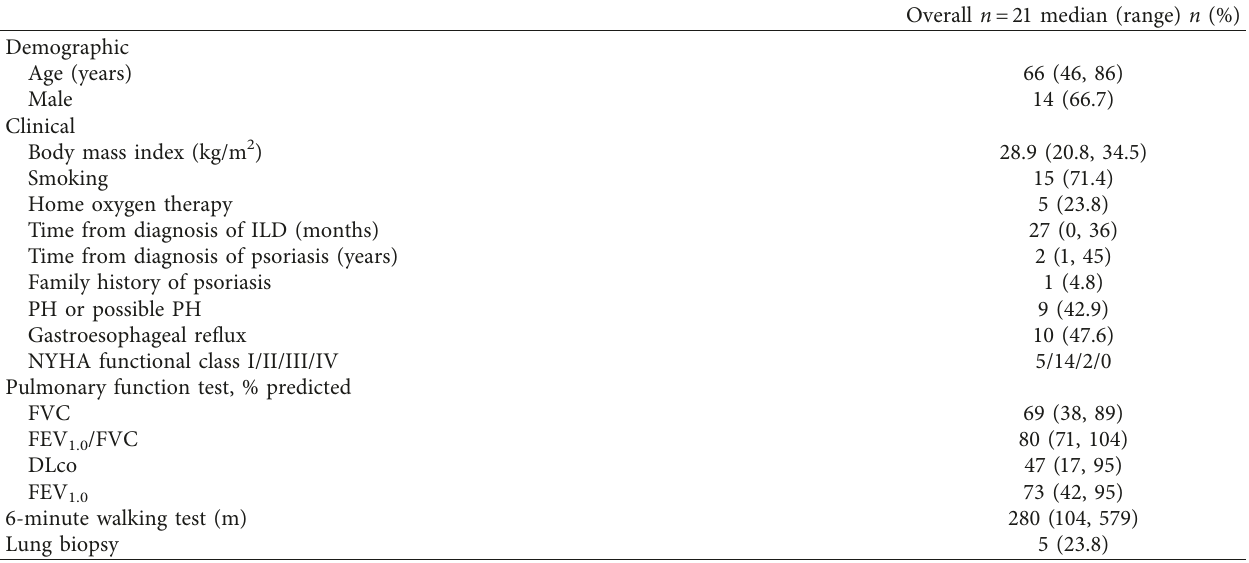
Table 1: Patient characteristics.